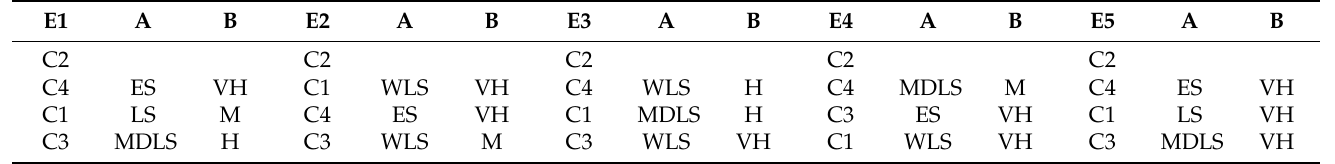
Table 2. Intercomparison of criteria in the IMF SWARA-Z method by five DMs.